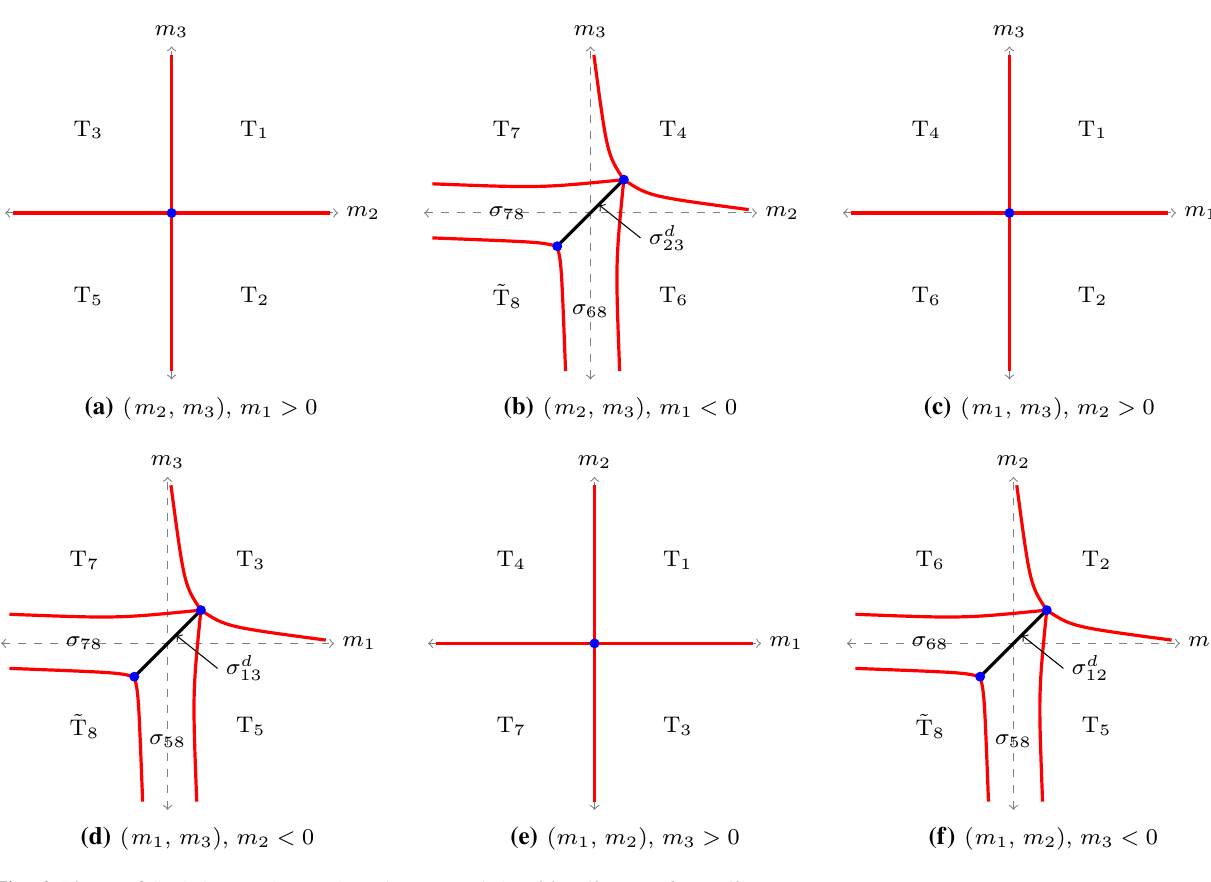
Fig. 6 Phases of SU ( N ) k + p ψ 1 + q ψ 2 + ( F − p − q )ψ 3 with F / 2 − q ≤ k < F / 2 − = k − p / 2 and F where k 2